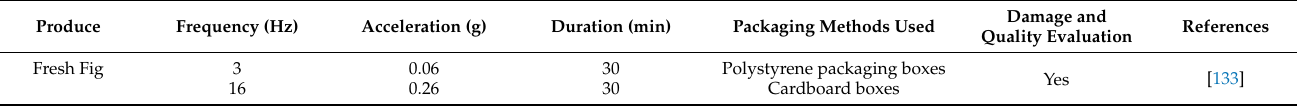
Table 6. Examples of some conditions used for simulated vibration of packed fresh fruit. Produce Damage and Quality